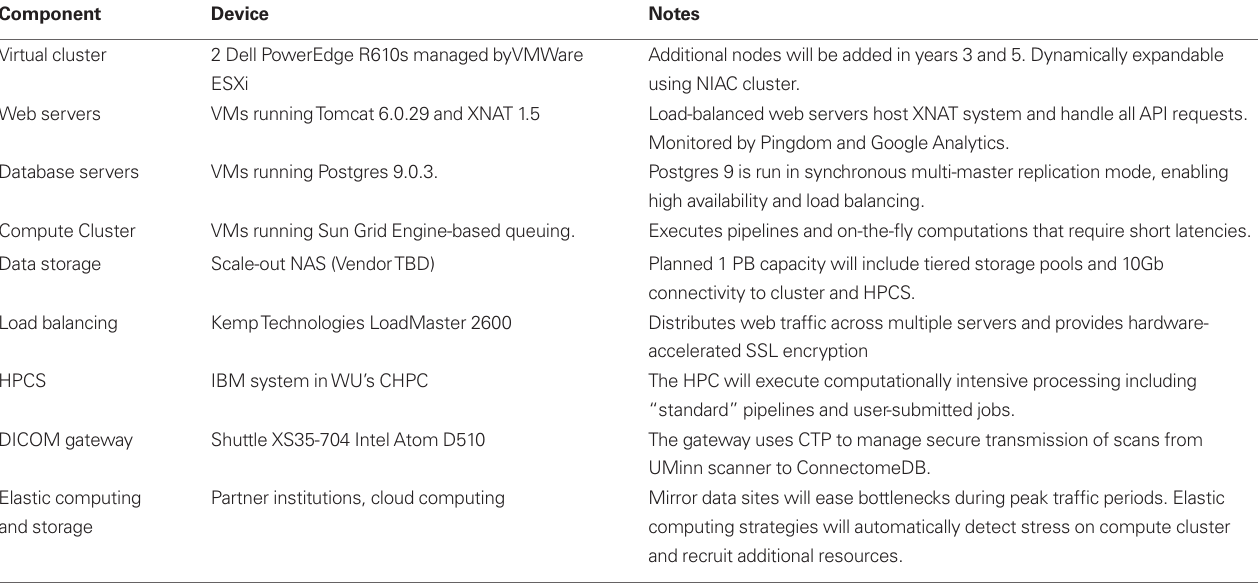
Table 1 | The HCP computing infrastructure.